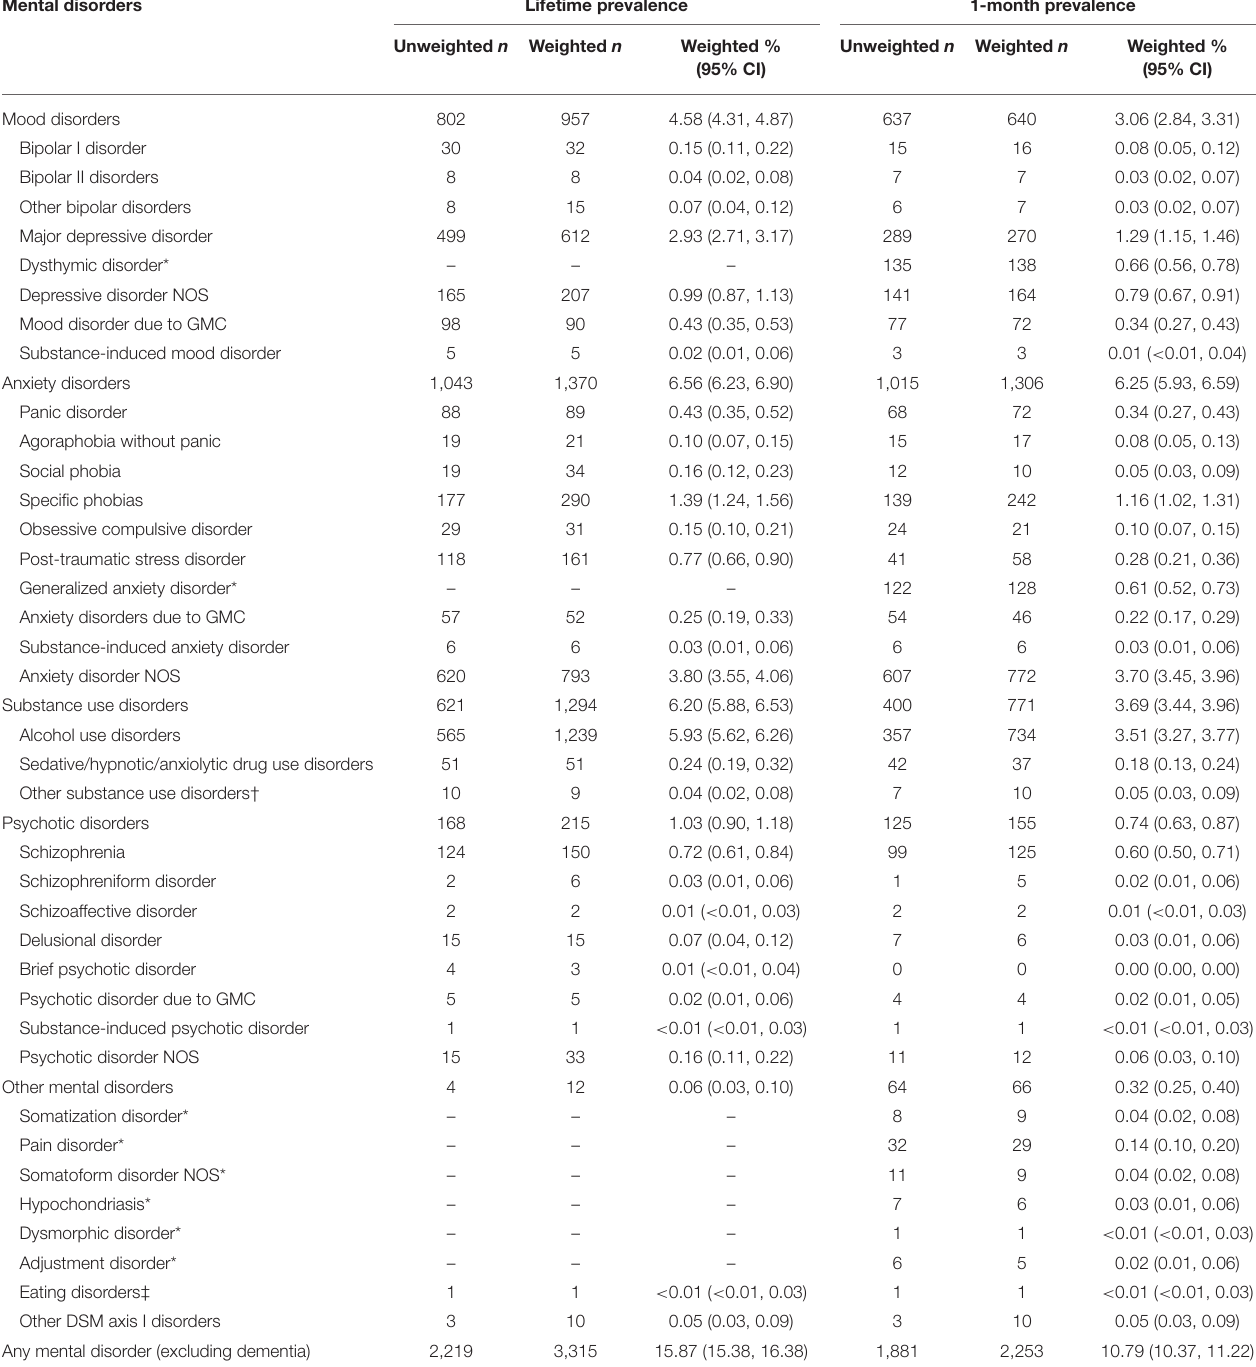
TABLE 2 | Weighted and unweighted lifetime and 1-month prevalence of mental disorders in Hebei province, China ( n =